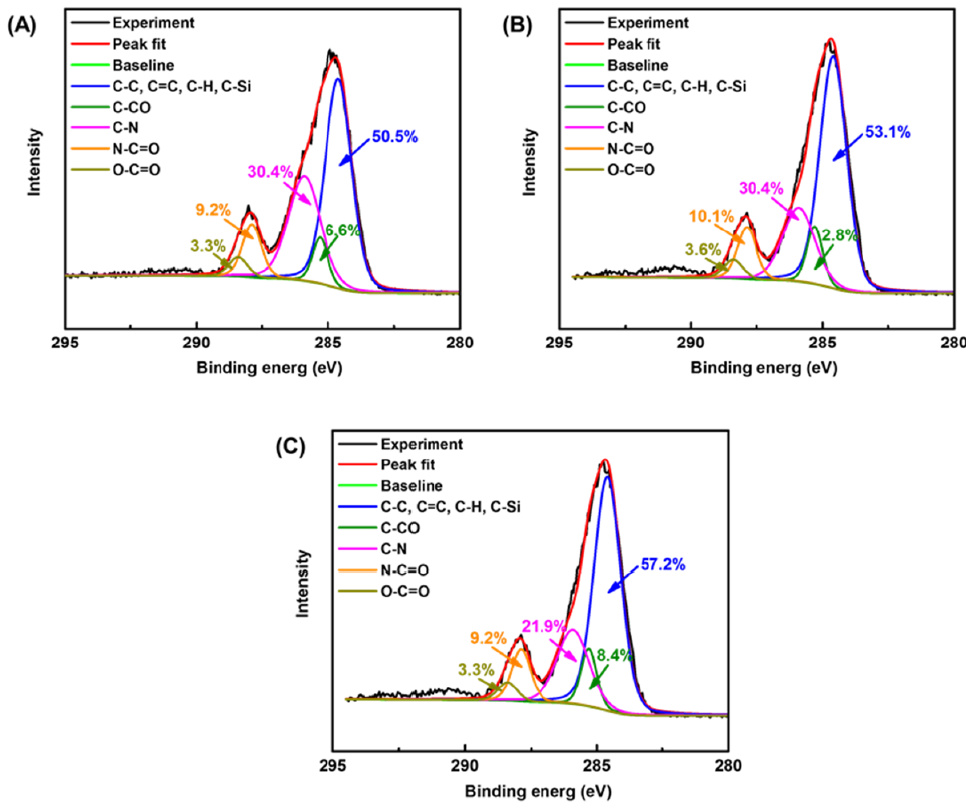
Figure 7. C 1s high-resolution spectra of the top surfaces for the membranes with different covalent silicon composition: ( A ) TFC membrane; ( B ) TFN-0.1 membrane; ( C ) TFN-0.2